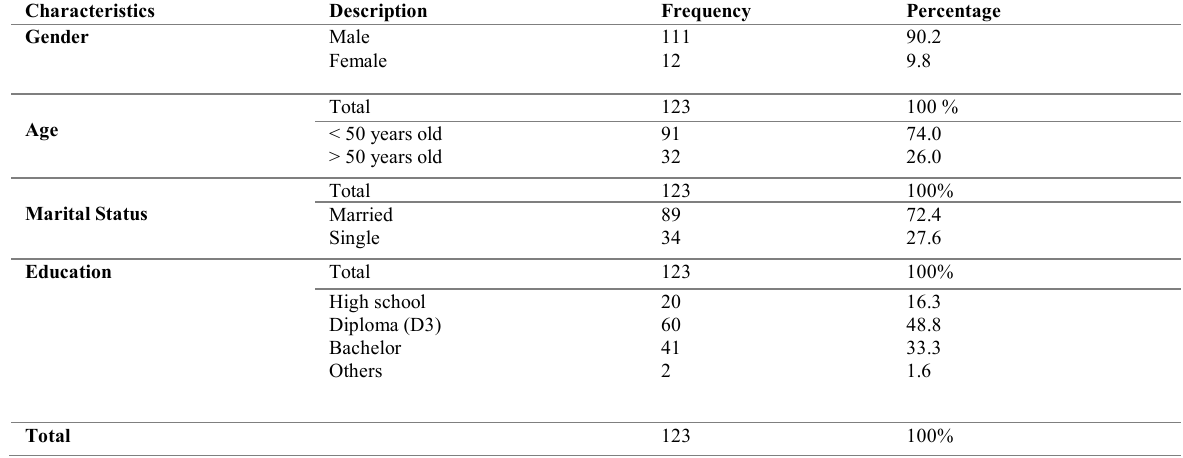
Table 1: Characteristics of Respondents